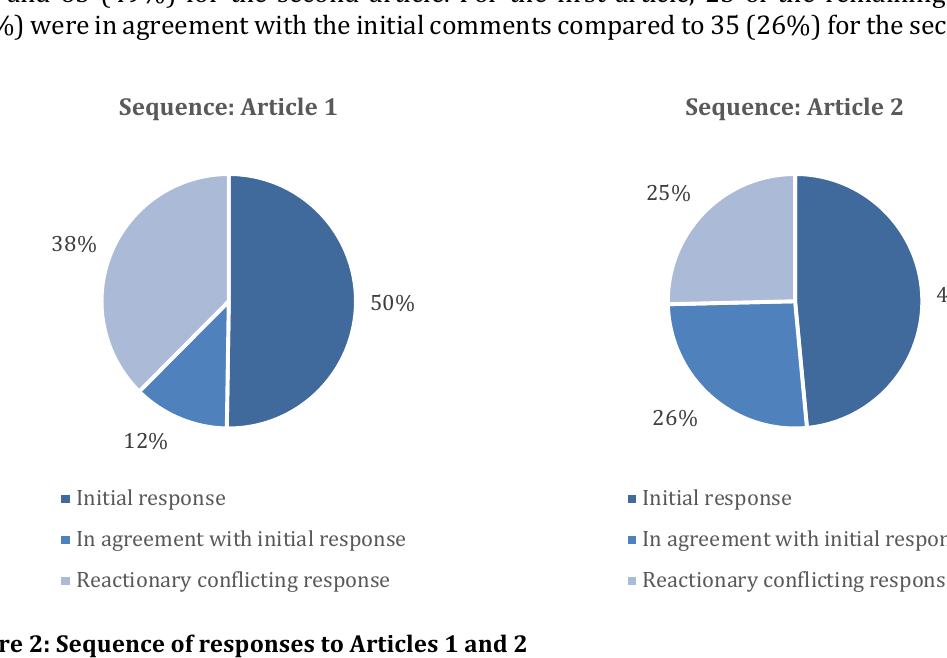
The attitude towards the victim represents the first of three principle questions examined in this analysis. Of all respondents, 120 (58%) in the first article compared to 56 (42%) in the second made no reference to the